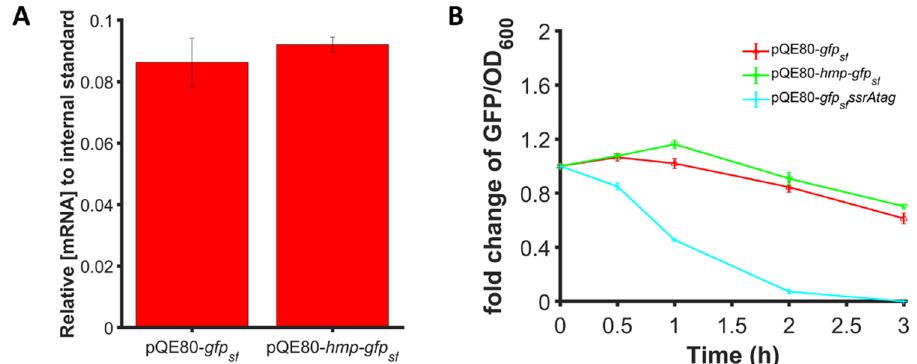
Figure 8. Expression enhancement is not due to transcript or protein degradation differences. ( A ) Transcript levels of gfp sf in wild-type harboring pQE80-P T5 - gfp sf (pXW09) , pQE80-P T5 - hmp-gfp sf (pXW08) after 1 h induction of 1 mM IPTG. Transcript levels shown are relative to the phzM internal standard spiked into each sample before RNA extraction. ( B ) Fold change of GFP/OD 600 after subtraction of the background signal (wild-type harboring pQE80L) of wild-type harboring pQE80-P T5 - gfp sf (pXW09) , pQE80-P T5 - hmp-gfp sf (pXW08) , and pQE80-P T5 -gfp sf ssrAtag (pXW21) following treatment with 100 µg/mL spectinomycin to stop translation. Cells were induced with 1 mM IPTG for 1 h before spectinomycin treatment. Data are the means of at least three independent replicates, and error bars represent the standard errors of the means.